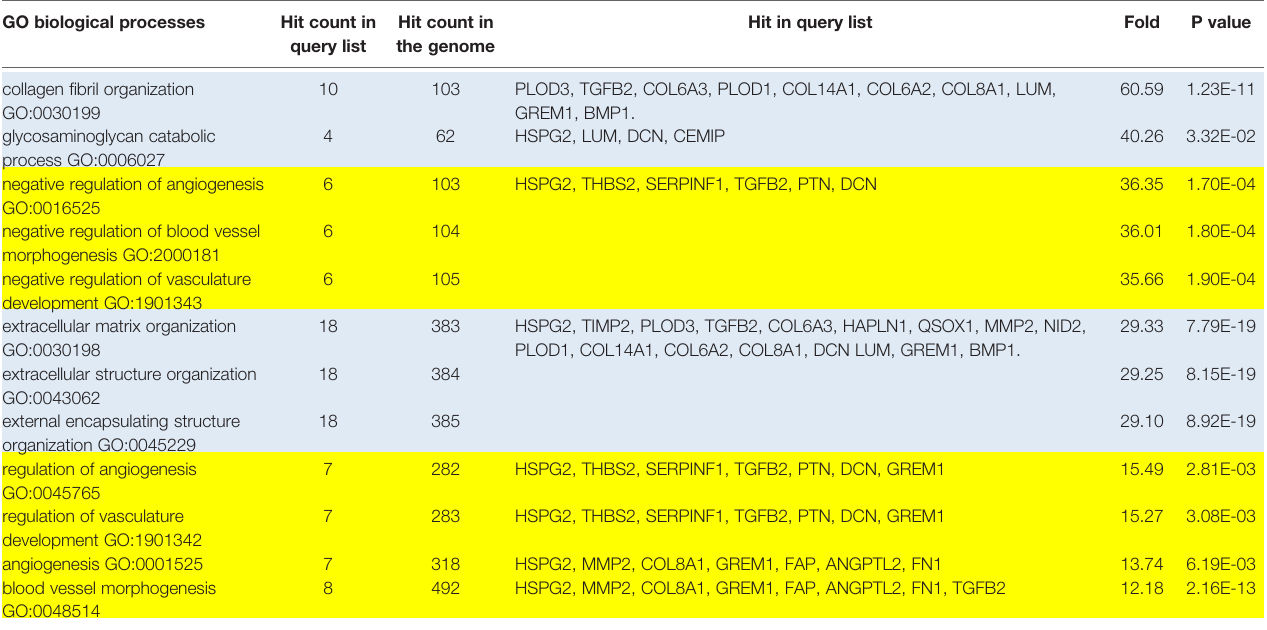
TABLE 6 | Most enriched GO terms: Biological Process, classed hierarchically by fold increase. GO biological processes